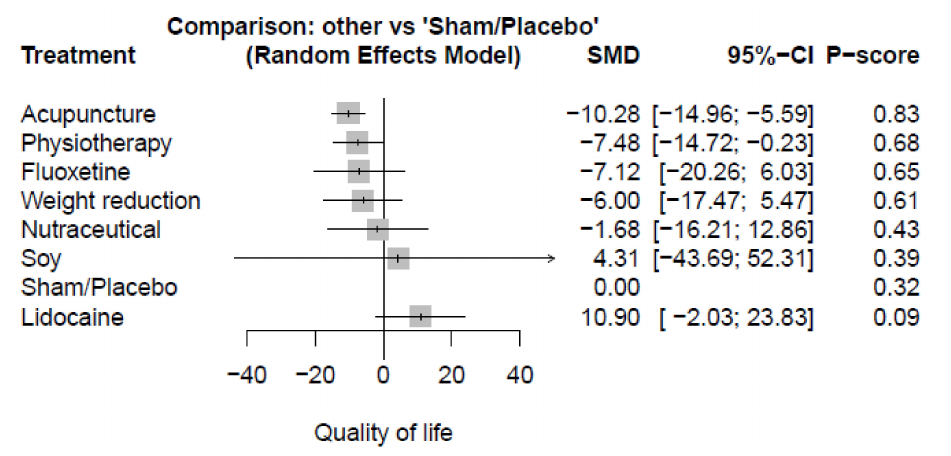
Figure 3. Plot of Quality of life (QoL); SMD: standardized mean difference, CI: confidence interval.